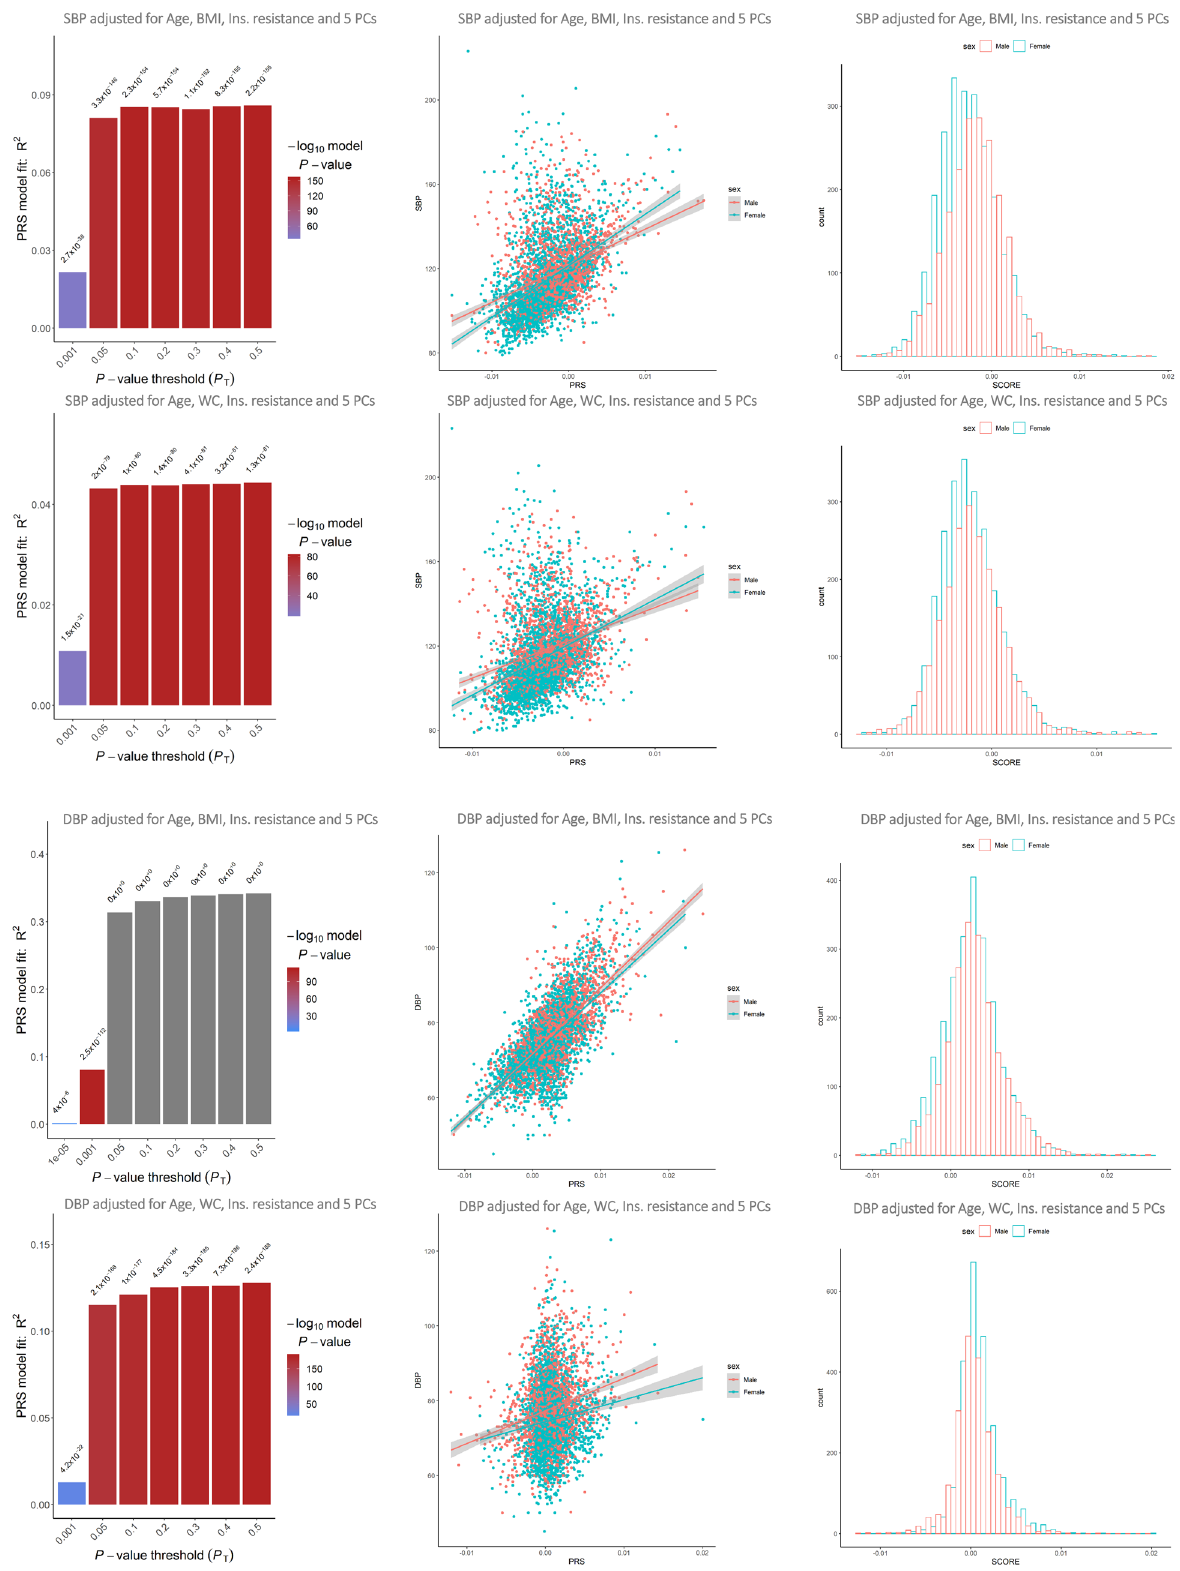
Figure 3. Predictive accuracy corresponding to a range of P value thresholds in regression models and the scatter plot of best fit PRS by sex in the discovery